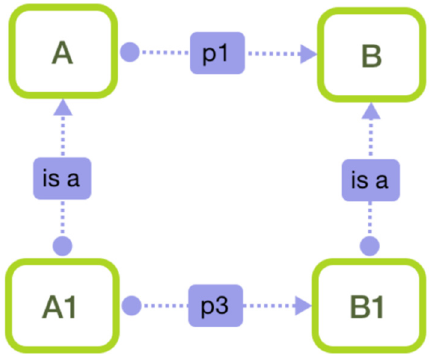
Figure 5. Special case 2 of is-a relation processing.